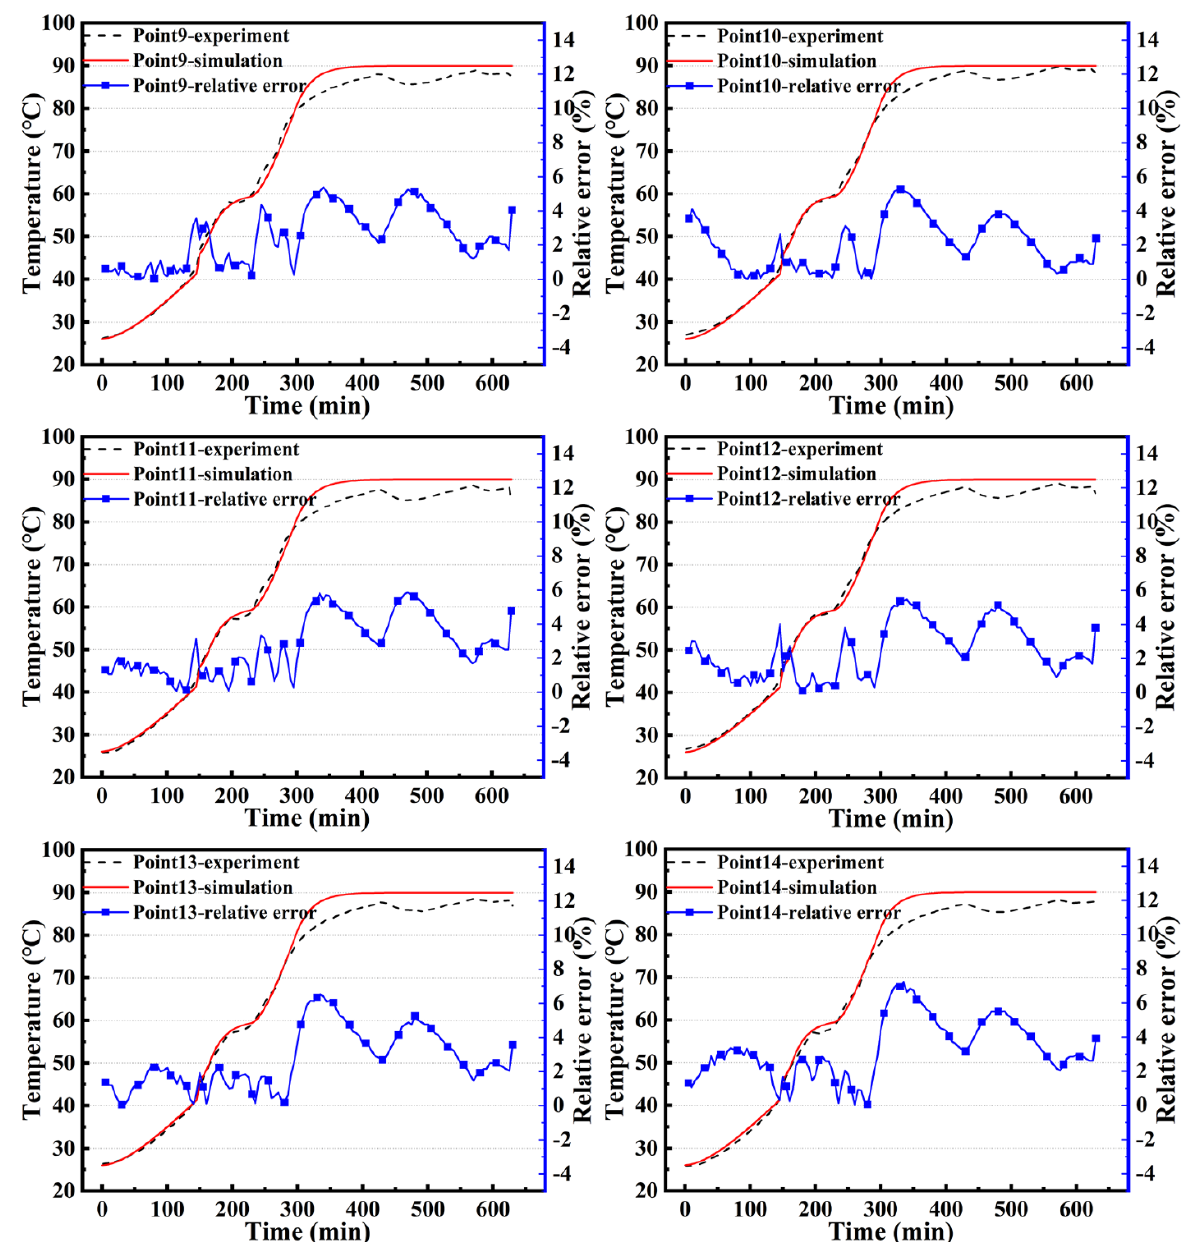
Figure 9. Comparison and relative errors between simulation results and measured temperatures at the fourteen points.